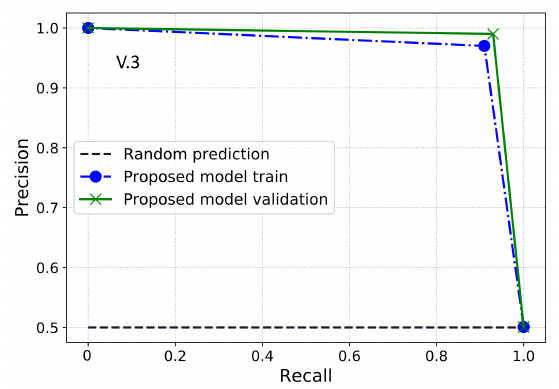
Figure 6. Proposed model’s ROC-AUC-based analysis with IQMOT.